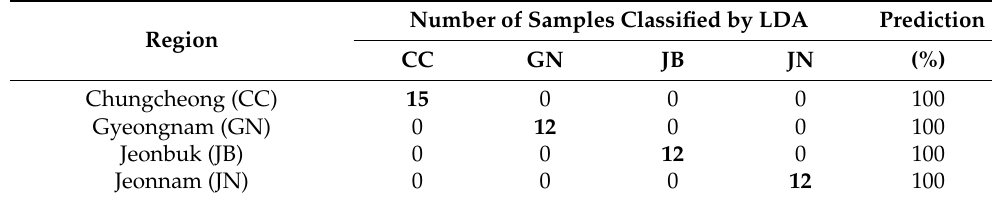
Table 3. Predicted geographical origins of clams from different provinces of Korea. Number of individual clams with geographical origins determined by LDA of fatty acid profiles. Each number represents a sample classified according to the predicted region, and prediction was performed using the number of samples (bolds) whose origin was well identified out of the total number of samples. The results are evaluated using cross-validation. Number of Samples Classified by LDA Prediction Region CC GN JB JN (%) Chungcheong